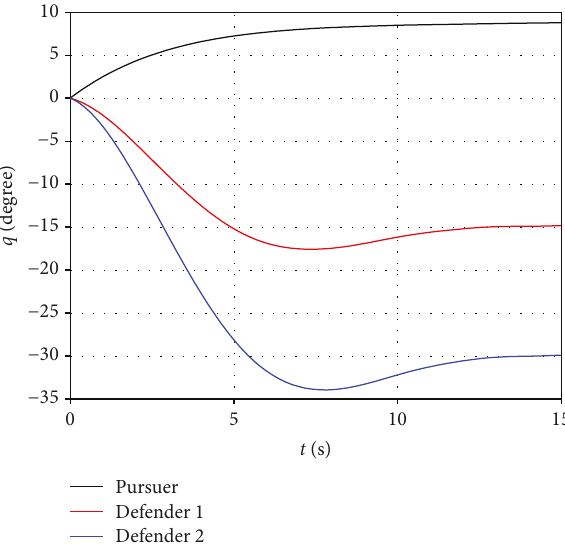
Figure 10: Intercept angle variation of the aircraft.